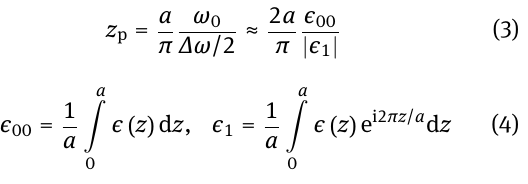
acts as an interface in which light is partially reflected and transmitted. The reflected light can interfere construc- tively, producing high reflectivity over a particular band- width of light. The grating period length, the degree of in- dex contrast between Bragg layers, and the number of pe- riods determine this reflectivity. For an infinite number of periods, Bragg gratings can ideally act as perfectly reflec- tive mirrors at wavelengths that satisfy the Bragg condi- tion (wavelengths that are four times the optical thickness of the layers) [51]. Realistically, perfectly reflecting mirrors are not achievable due to practical fabrication